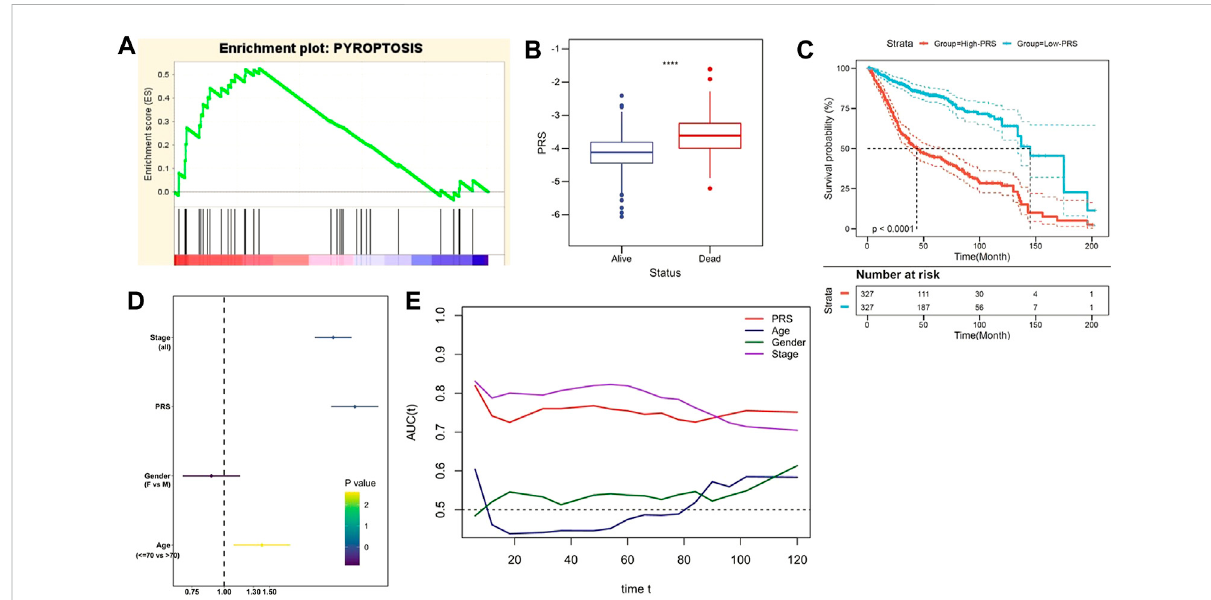
FIGURE 3 The gene signature predicts worse survival in the training set. (A) GSEA con fi rmed the status of pyroptosis in the two subgroups. (B) The follow up data indicated that PRS signi fi cantly decreased in patients alive. (C) Kaplan – Meier survival curve showed that patients with lower PRS enjoyed better outcomes. (D) Multivariate Cox regressionanalysis demonstrated that PRS was an independent risk factor for OS. (E) tROC analysis suggested that PRS was an accurate variable for predicting the